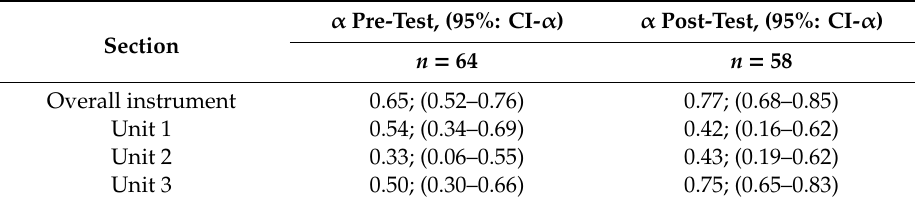
Table 4. Internal consistency and confidence intervals by mode of administration and Unit.